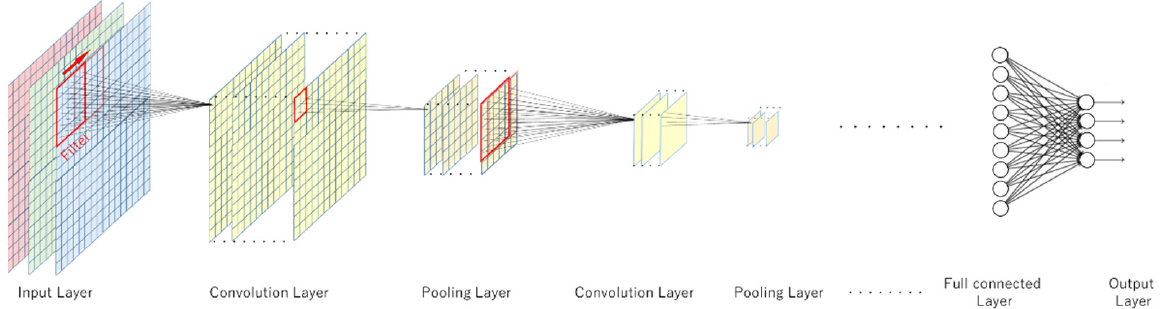
Figure 4. Illustration of the convolution neural network. AlexNet (2012) [30], GoogleNet (2014) [31], VGG (2014) [32], and ResNet (2015) [33]